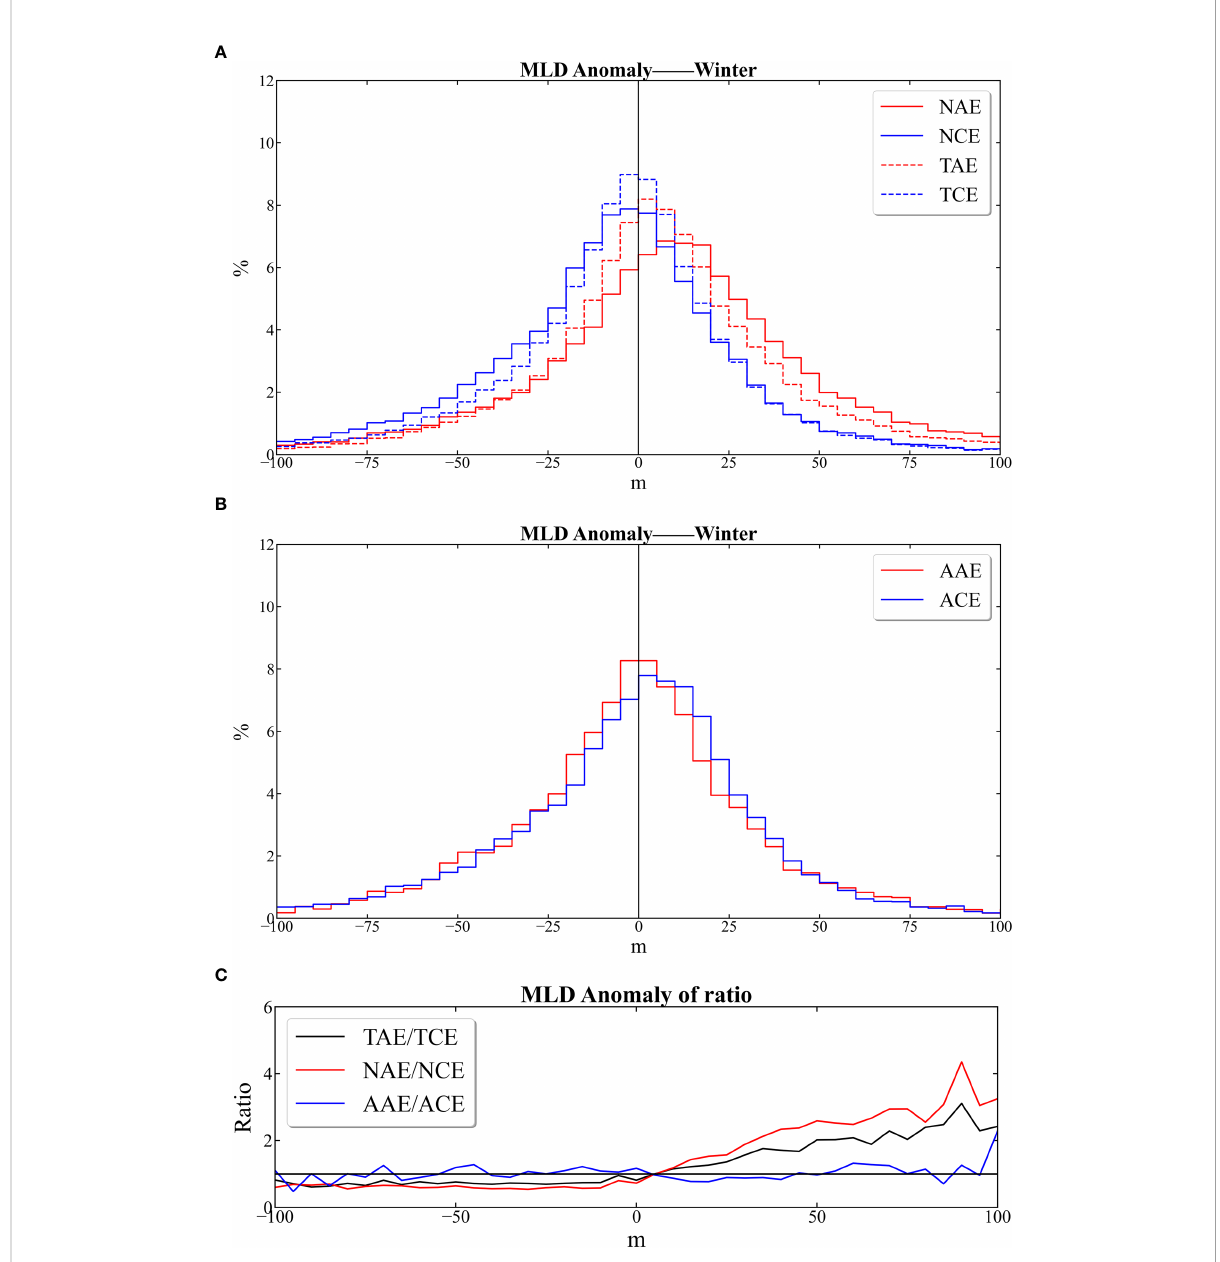
FIGURE 7 Histogram of global eddy-centric winter time MLD anomalies, including total matching eddies (A) , normal eddies (A) and abnormal eddies (B) . The solid (dashed) red and blue lines in (A) represent NAE (TAE) and NCE (TCE), the corresponding ratios are shown as solid red and black lines in (C) , respectively. The scale of (B) is shown by solid blue lines in (C) . The solid red and blue lines represent AAE, and ACE in (B) . MLD, mixed layer